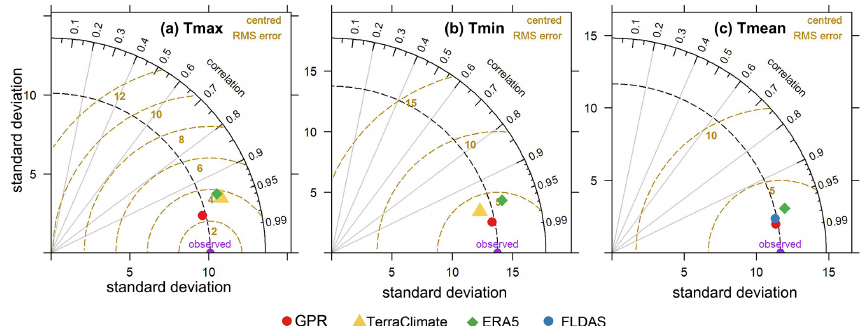
Figure 11. Taylor diagrams displaying a statistical comparison with observations between our products generated using the GPR model and the other products under the same spatial resolution. Given the overlapping time of the data sets, January 1979 to December 2019 was used to compare Tmax and Tmin, and January 1982 to December 2019 was used to compare Tmean. Comparisons for each month are presented in the Supplement (Figs.